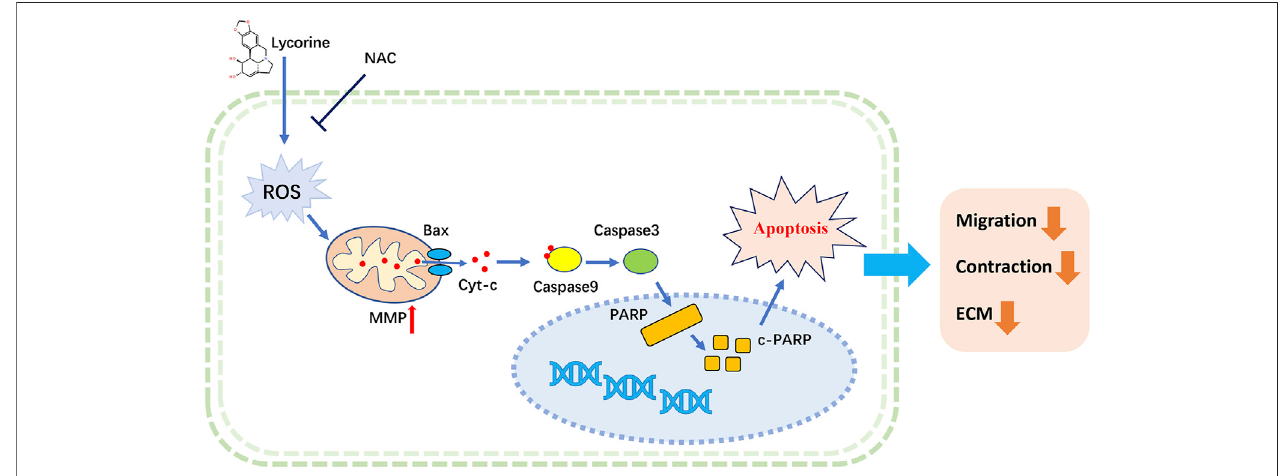
FIGURE 7 | A Schematic diagram for ROS-mediated mitochondrial apoptosis of lycorine in hypertrophic scar fi broblasts